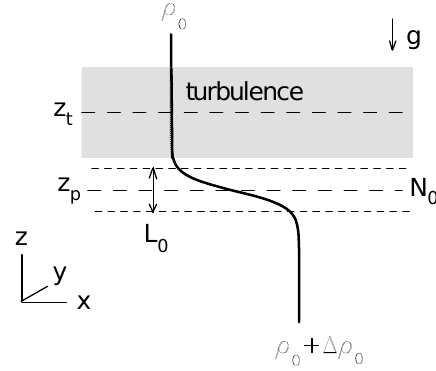
Figure 1. Schematic of the numerical experiment: x , y and z are the Cartesian coordinates; ρ 0 is the density above the pycnocline; (cid:49)ρ 0 the density jump across the pycnocline; g the gravity acceleration, N 0 the buoyancy frequency in the pycnocline center; L 0 the pycn- ocline thickness; z p and z t the locations of the pycnocline and the turbulent layer